Question: Write a single sentence explaining what this figure depicts.
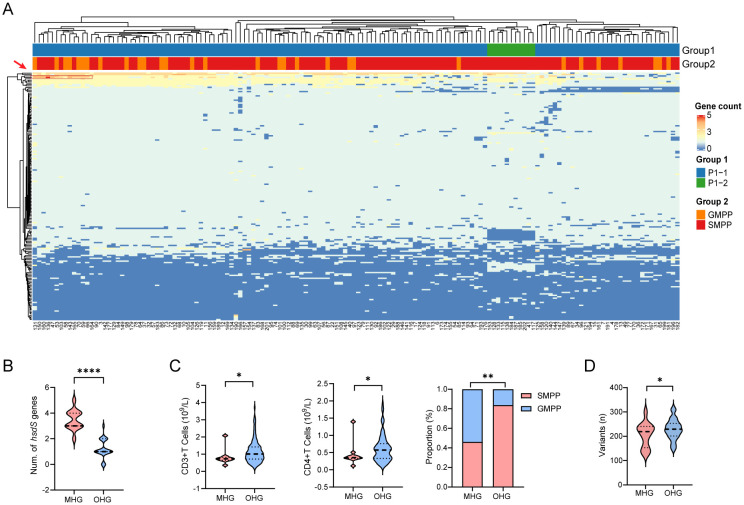
Answer: Genotypic and phenotypic comparison of hsdS homologs. (A) Heatmap showing homologous gene clusters across M. pneumoniae strains. Columns represent strains and rows represent homologous gene clusters. Group 1 denotes the P1 classification, while Group 2 indicates the disease severity. The red arrow and box highlight the MHG group with more hsdS homologous genes. (B) The number of hsdS homologs per isolate from the MHG and OHG groups. (C) Clinical features of pediatric patients infected by M. pneumoniae . (D) Burden of genomic variation in isolates from the MHG and OHG groups. Fisher’s exact test or Mann-Whitney U test was used as appropriate., *, P < 0.05. **, P < 0.01. ****, P < 0.0001.